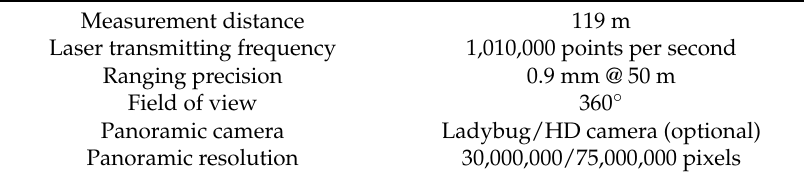
Figure 2. HiScan-Z mobile laser scanning system. Table 1. HiScan-Z laser scanning system technical specifications.